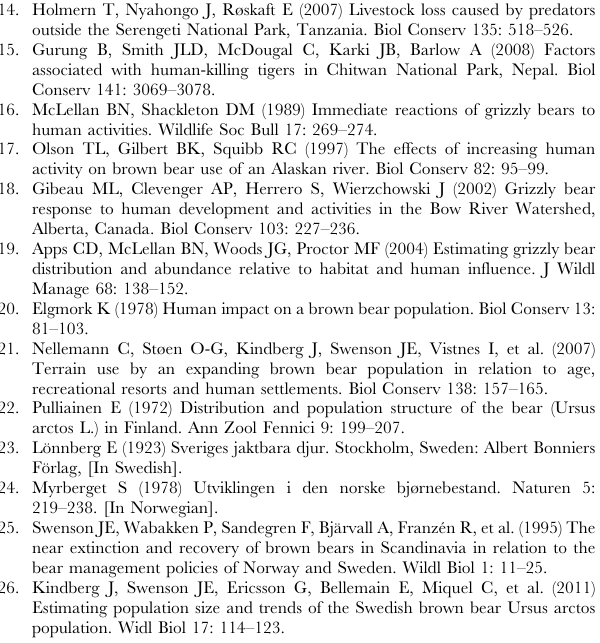
Table S1 List of candidate and selected models (lowest AIC value) for remaining or leaving the initial site, and the flight initiation distance (FID) for brown bears when approached by humans on foot in central Sweden in 2006–2009, respectively. We show AIC values, differences in AIC values between the selected model and each candidate model ( D AIC), and AIC weights ( Wi